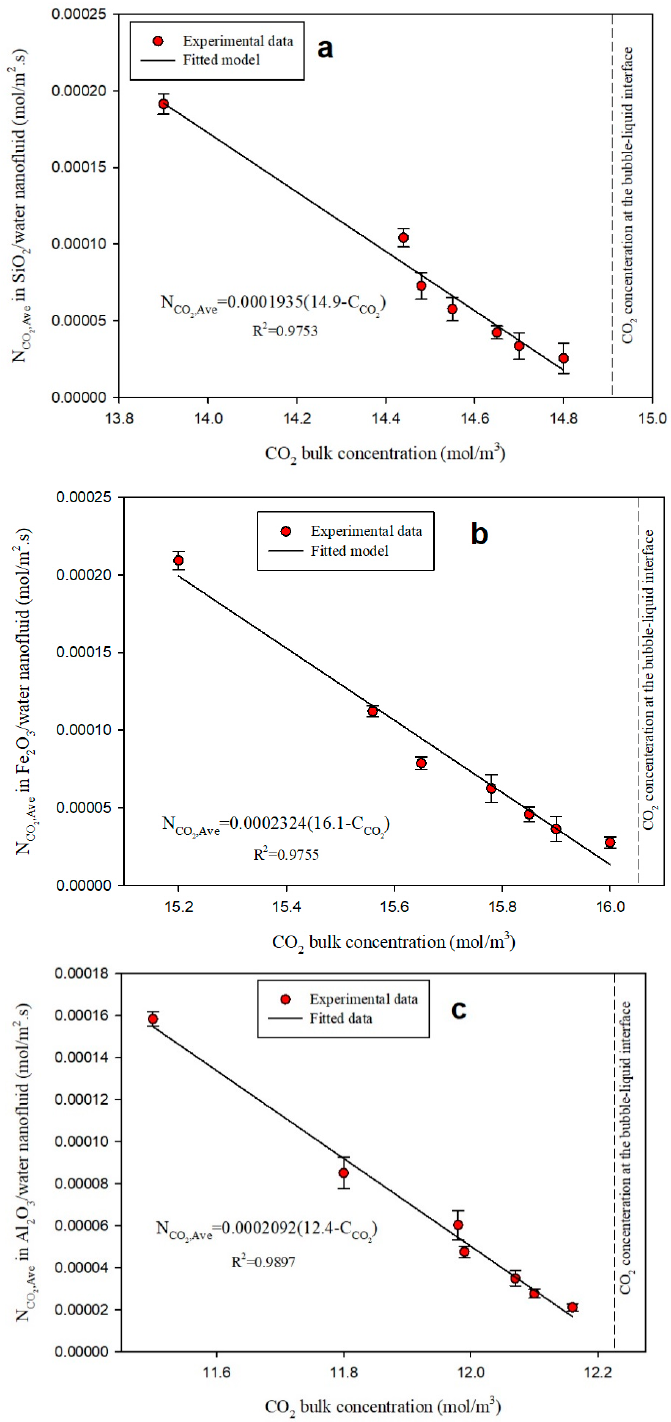
Figure 9. Average molar flux versus CO 2 bulk concentration for ( a ) SiO 2 /water, ( b ) Al 2 O 3 /water and ( c ) Fe 2 O 3 /water nanofluids. Fe 2 O 3 / water